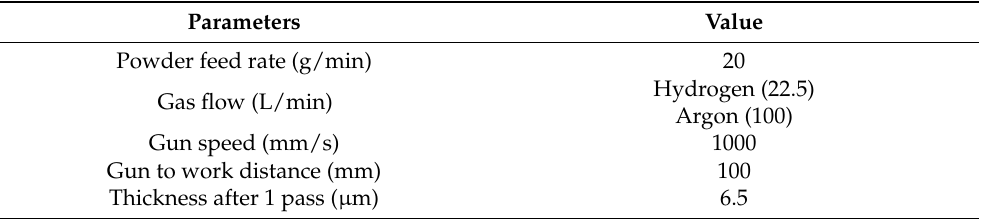
Table 2. Air plasma spraying parameters for REO and 8YSZ